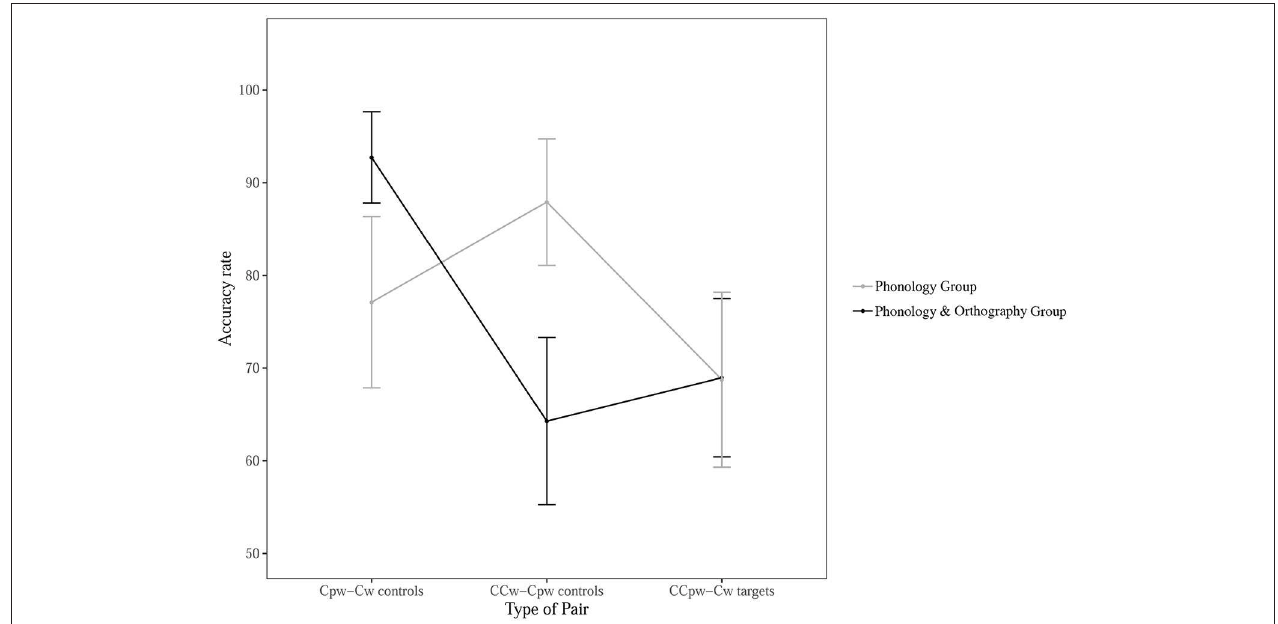
FIGURE 4 | The proportion of correct responses as a function of group (Phonology, Phonology & Orthography) and type of pair (C pw -C w , CC w -C pw , CC pw -C w ) in the rhyme judgement task. Bars represent 95% CI s.